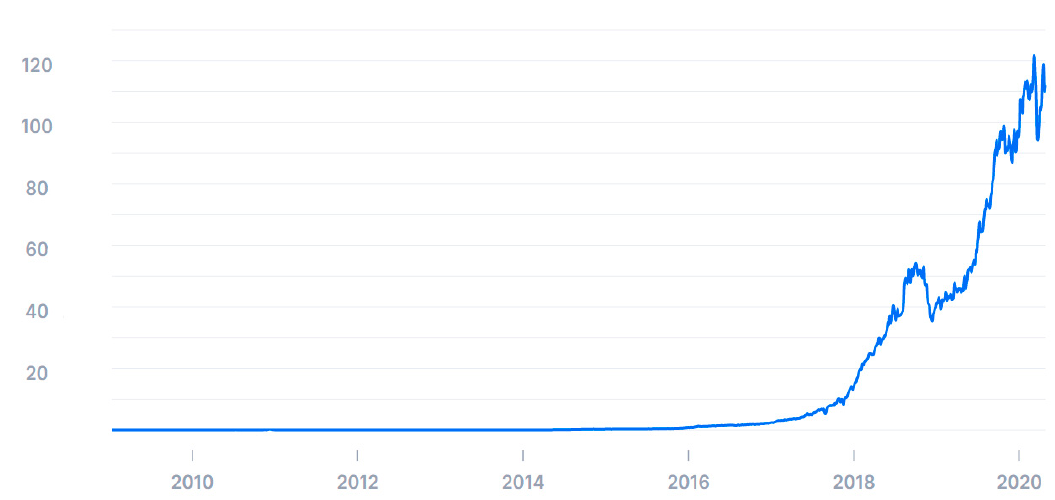
Figure 3. Bitcoin hashrate, EH/s. Source: https://www.blockchain.com.